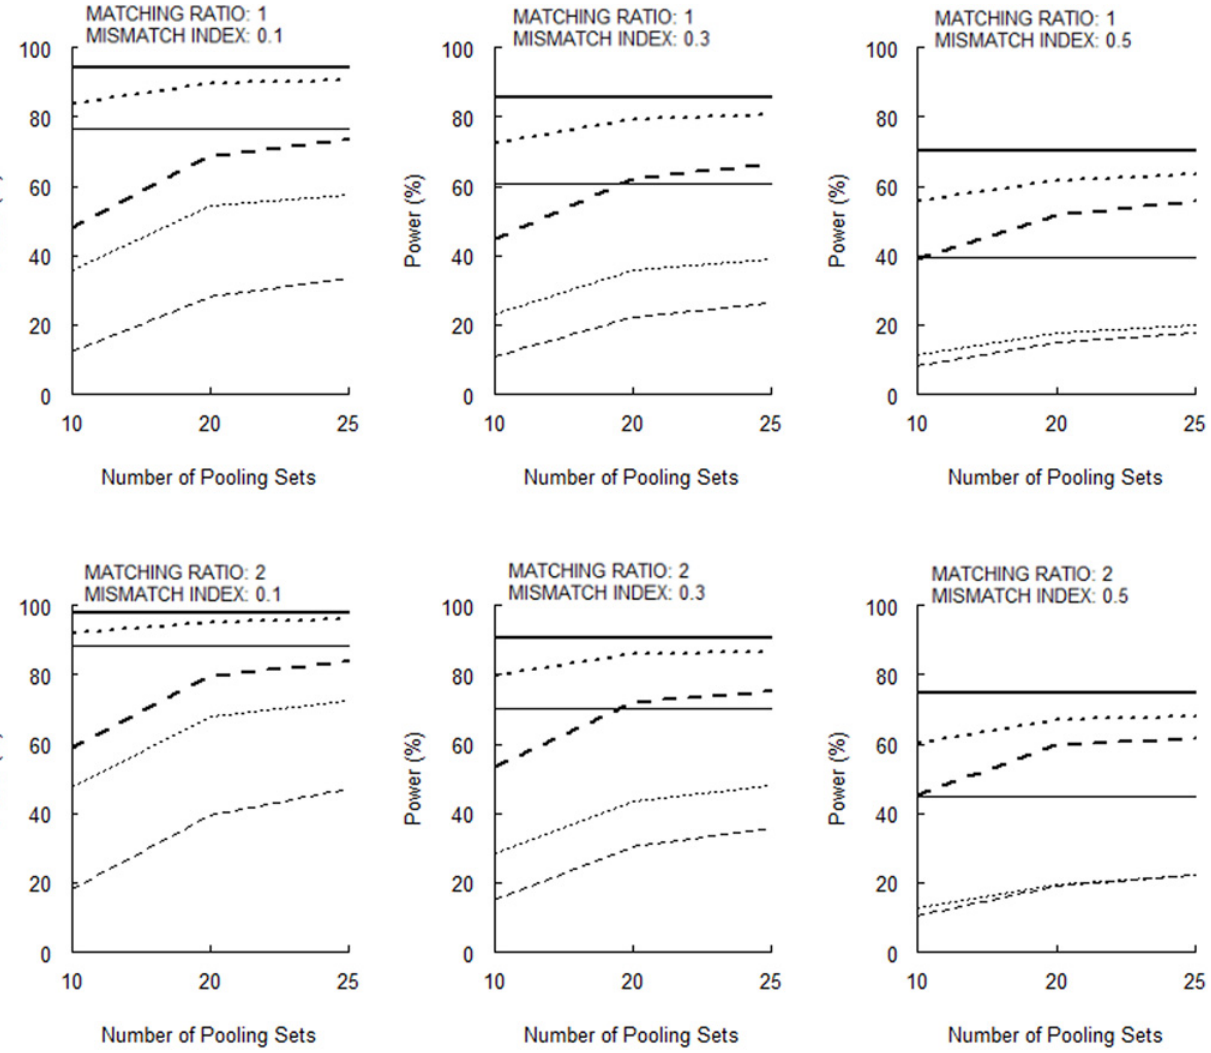
Fig 4. Powers of the permutation test with a total of 50 null markers (bold broken lines, σ = 0.05, α = 0.05; thin broken lines, σ = 0.05, α = 0.005; bold dotted lines, σ = 0.01, α = 0.05; thin dotted lines, σ = 0.01, α = 0.005). The horizontal bold and thin solid lines indicate the powers for the individual genotyping with stratum matching and genomic control for α = 0.05 and α = 0.005, respectively.